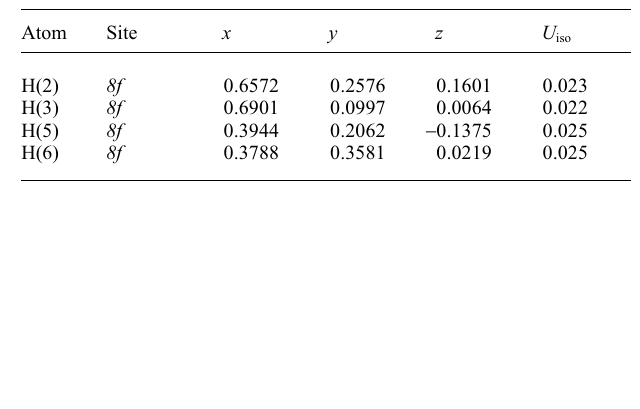
Table 2. Atomic coordinates and displacement parameters (in Å 2 )